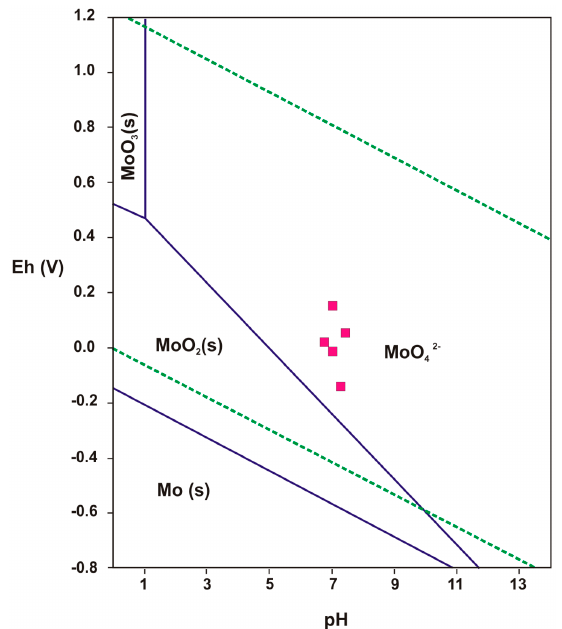
Figure 4. Eh–pH plot of the water samples in the system Mo-O-H. Mo = 10 − 10 m mole, 298.15 K, 105 Pa [38]. Table 2. Chemical parameters of the selected groundwater samples. Well No.